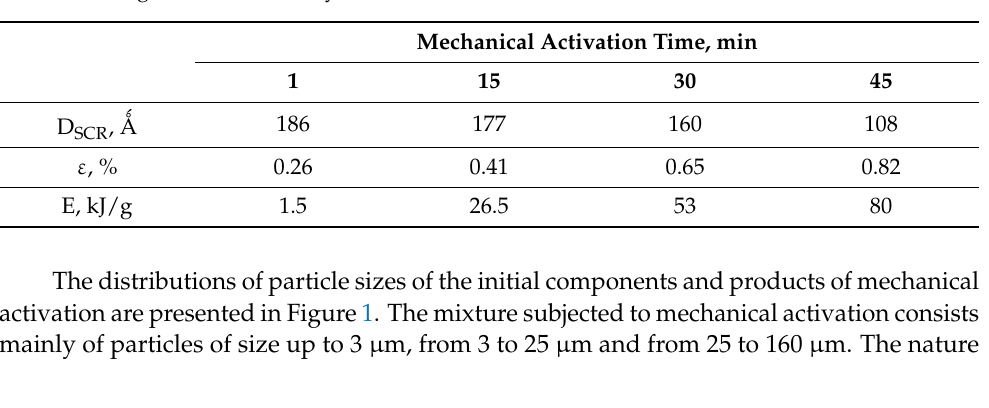
Table 1. Changes in the size of crystallites and the microstrain value of iron